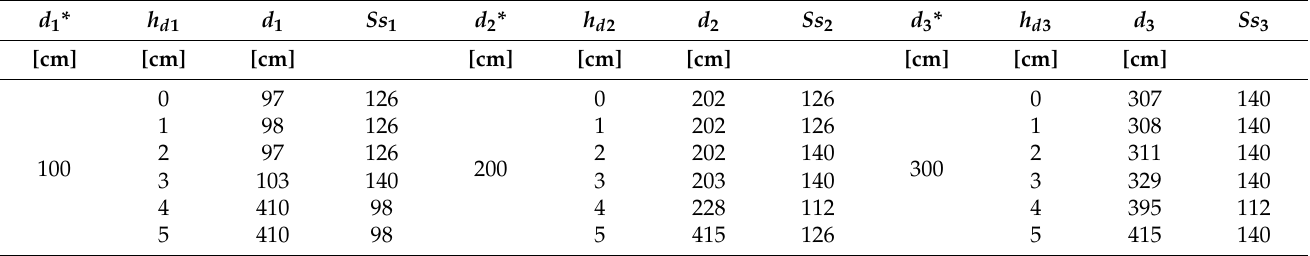
Table 3. Left horizontal displacement experimental results with tramcar target.